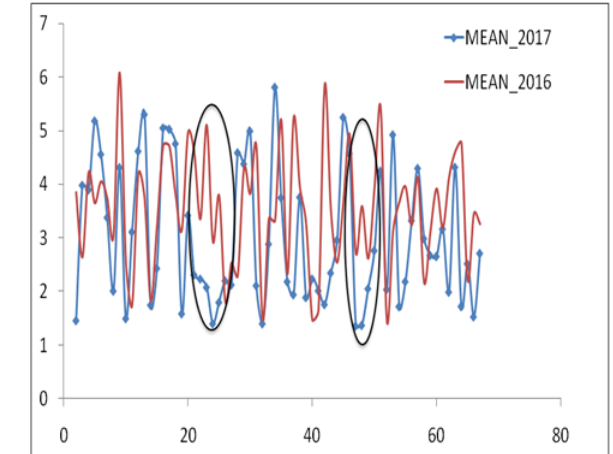
Figure 3: Mean backscatter values comparing between 2016 and 2017 over delineated fields